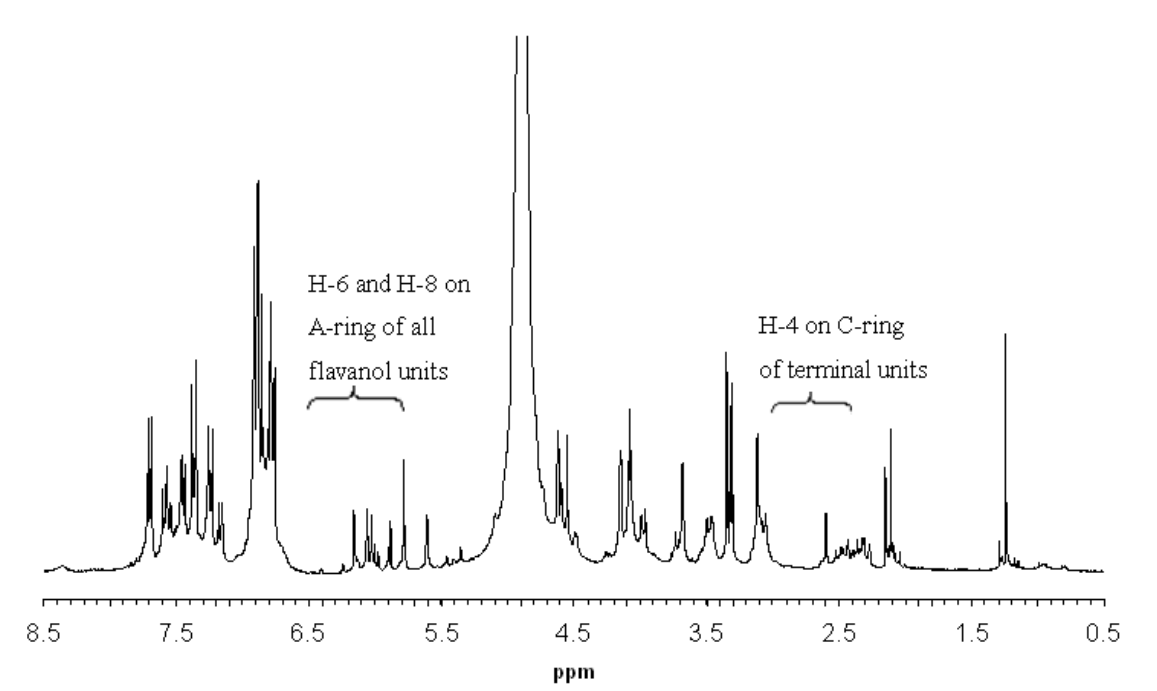
Figure 2. Room temperature 300 MHz 1 H-NMR spectrum of proanthocyanidins from the rhizomes of Selliguea feei (solvent, CD 3